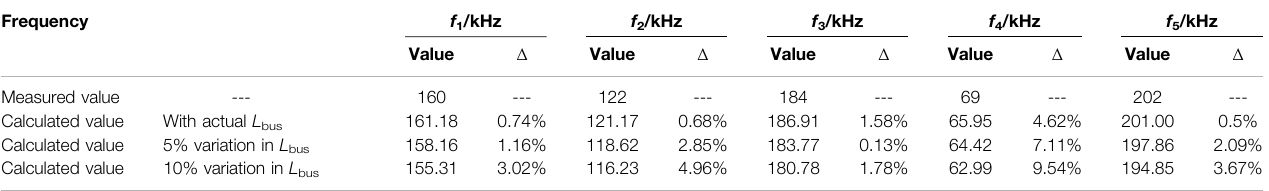
TABLE 1 | Comparison between the theoretical and measured values of network resonance and impact of L bus variation. Frequency